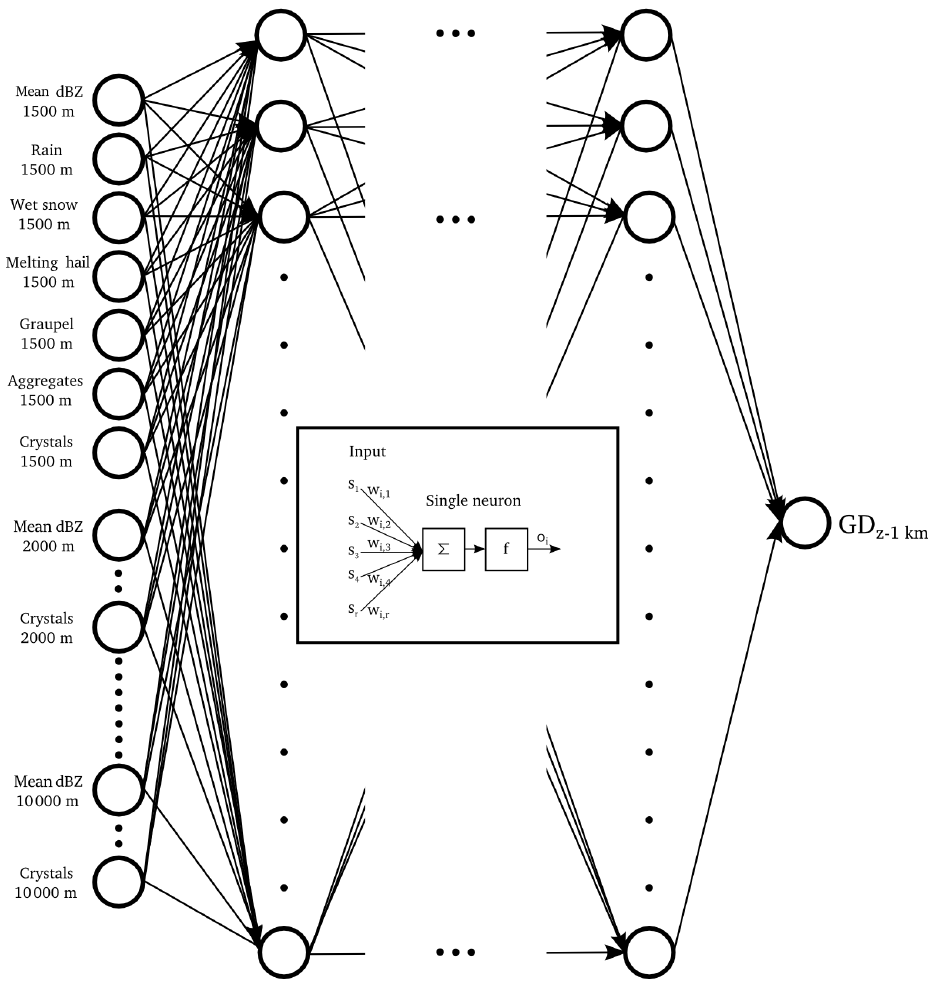
Figure 3. Example of a multi-input single-output MLP model and setup as used in this study. The number of input neurons M equals the number of V predictors (reflectivity, HC proportions) multiplied by H height levels